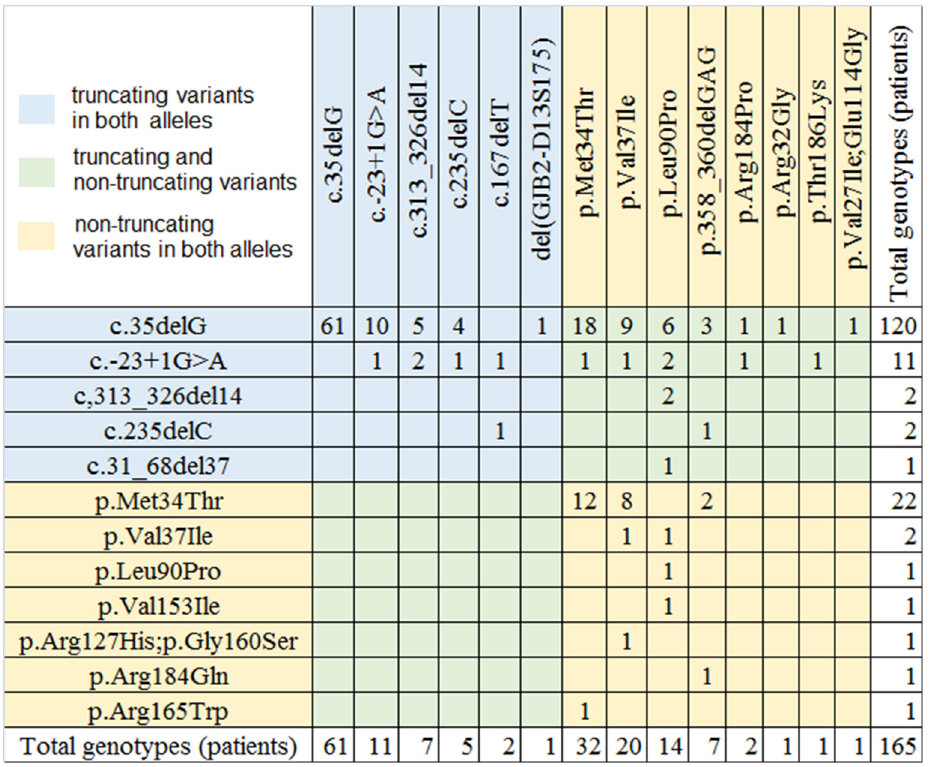
Figure 1. The matrix of GJB2 gene mutations and genotypes (n = 165) identified in our study group (T/T genotypes are blue, T/NT genotypes are green, NT/NT genotypes are yellow). The total number of pathogenic and likely pathogenic alleles is 330.